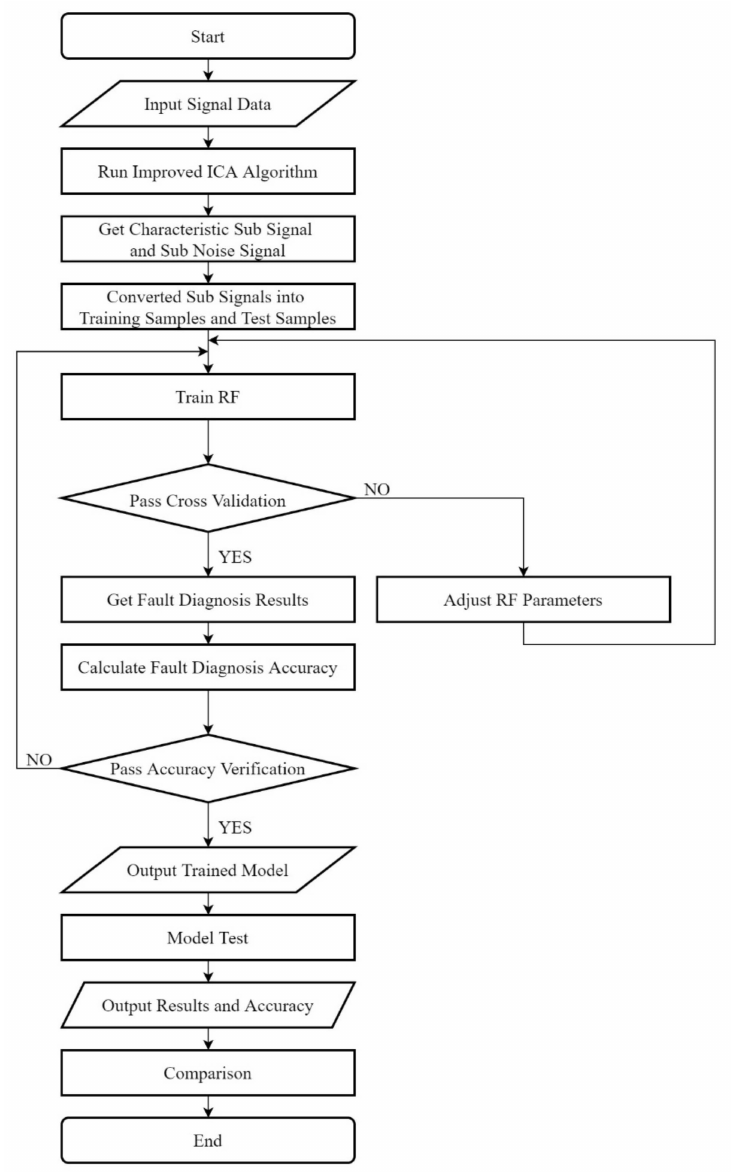
Figure 4. Fault Diagnosis Flow